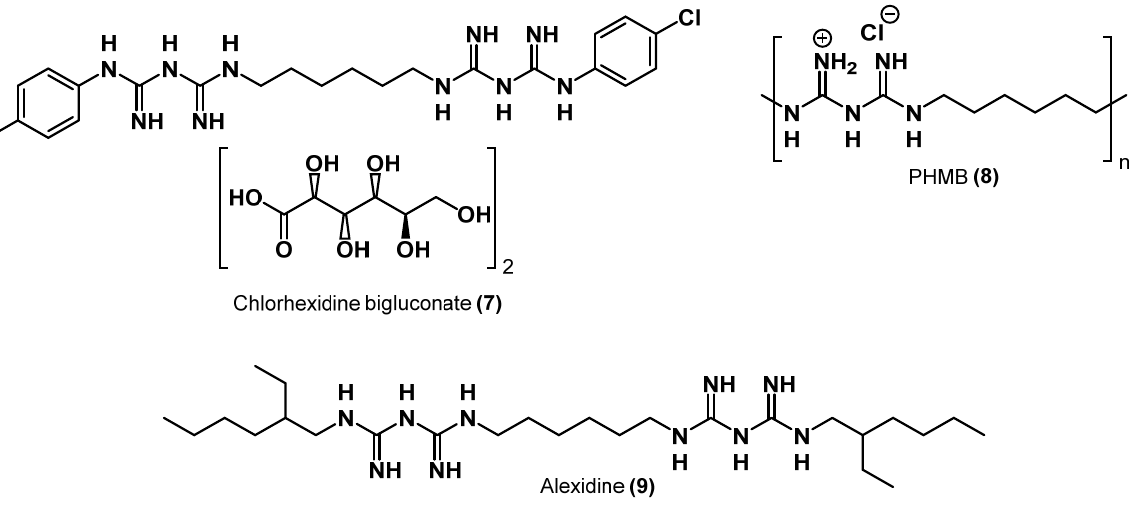
Figure 6. Commercial QACs–biguanide derivatives.